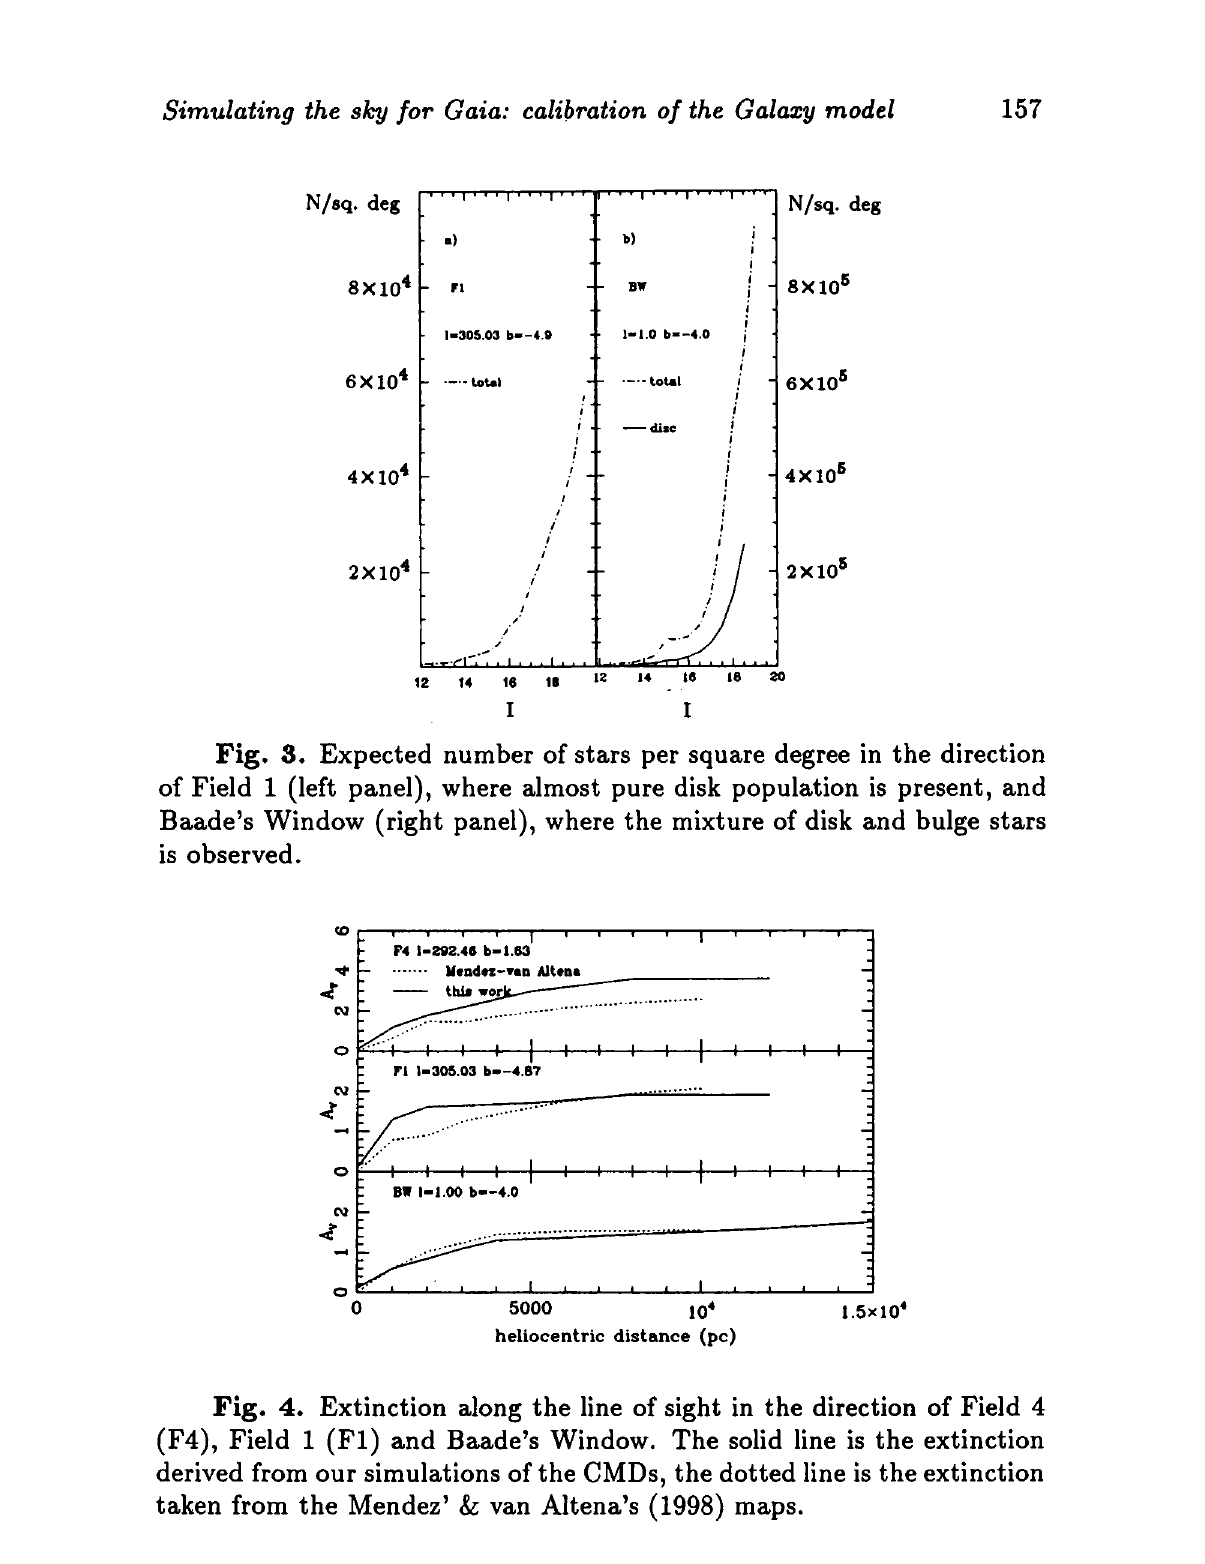
Fig. 4. Extinction along the line of sight in the direction of Field 4 (F4), Field 1 (Fl) and Baade's Window. The solid line is the extinction derived from our simulations of the CMDs, the dotted line is the extinction taken from the Mendez' L· van Altena's (1998)